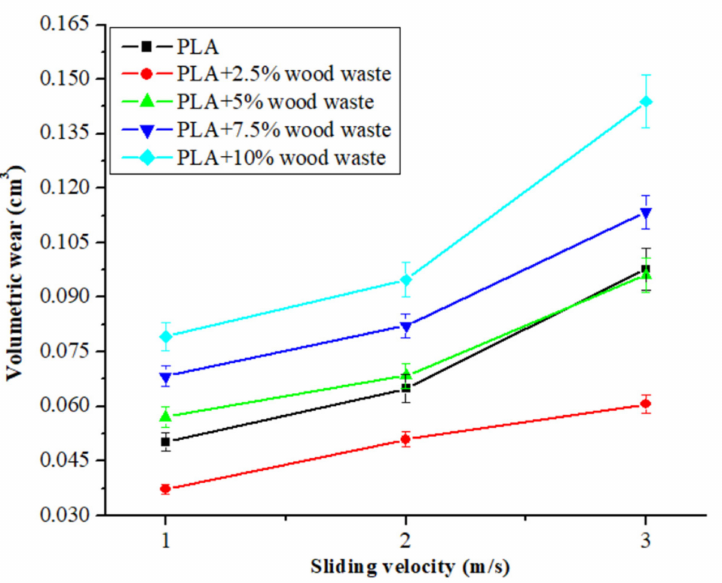
Figure 4. Volumetric wear of the composites as a function of sliding